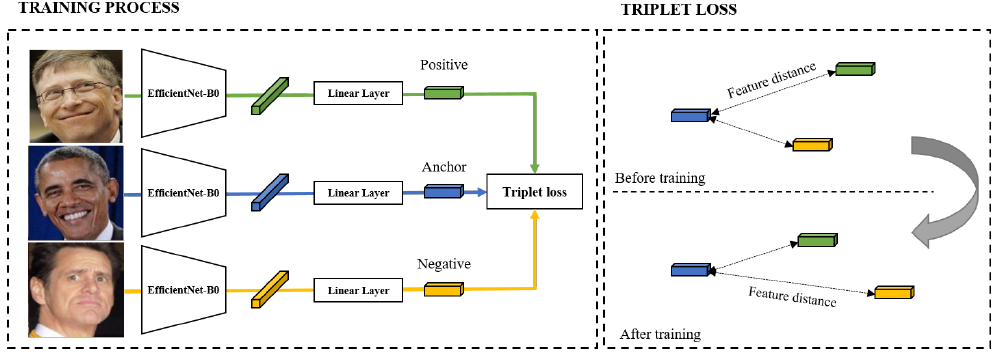
Figure 5. Architecture for Facial Expression Feature. This represents the training process and loss for deep learning-based facial expression feature